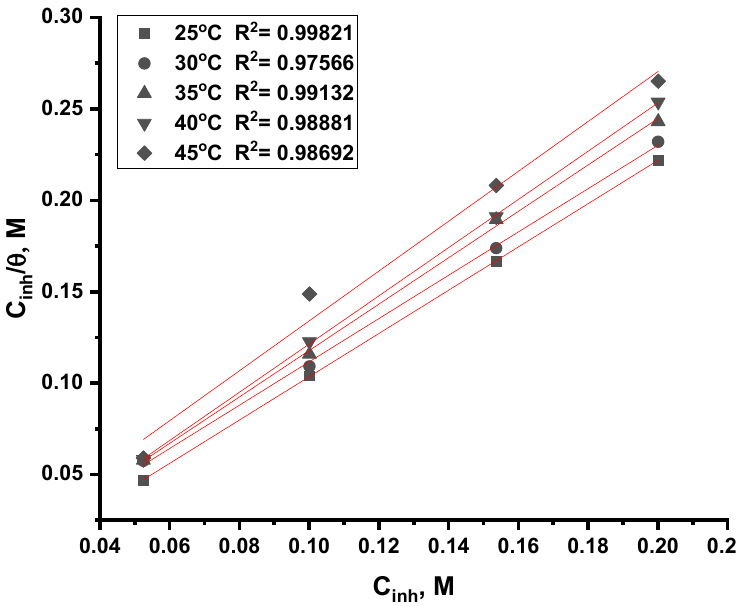
Figure 10. Langmuir adsorption plot as C/ θ vs. C, M of ACR-2 for corrosion of copper in 1.0 M HNO 3 solution at all temperatures.